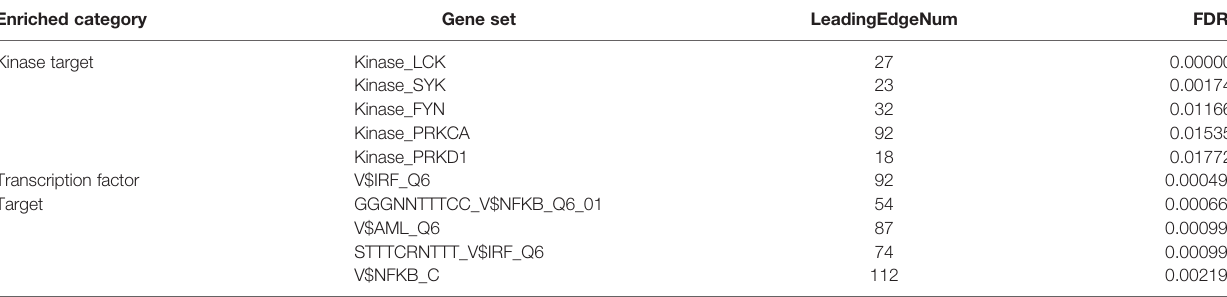
FIGURE 6 | Signi fi cantly enriched GO annotations and KEGG pathways of GOLPH3 using GSEA in LUAD (LinkedOmics). (A) Cellular component (CC). (B) Enrichment plot of ribosome in CC. (C) Biological process (BP). (D) Enrichment plot of translational initiation in BP. (E) Molecular function (MF). (F) Enrichment plot of structural constituent of ribosome in MF. (G) KEGG pathway. (H) Enrichment plot of oxidative phosphorylation pathway in KEGG. GSEA, Gene Set Enrichment Analysis; LUAD, lung adenocarcinoma; GO, Gene Ontology; KEGG, Kyoto Encyclopedia of Genes and Genomes. All results are available online. TABLE 2 | The kinases and transcription factors — target networks of GOLPH3 in lung adenocarcinoma. Enriched category Gene set LeadingEdgeNum